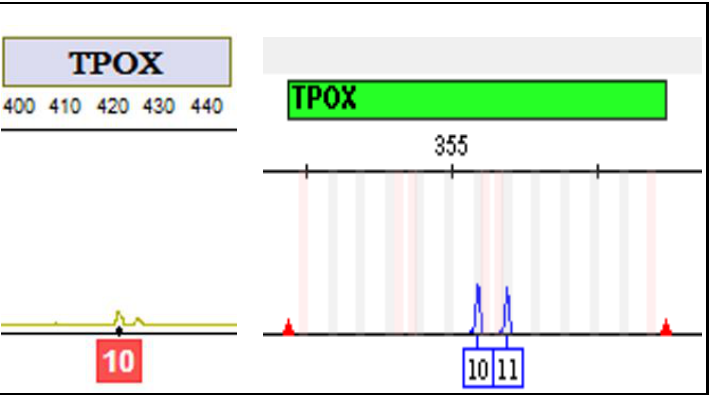
Figure 1. The allelic dropout at TPOX marker.